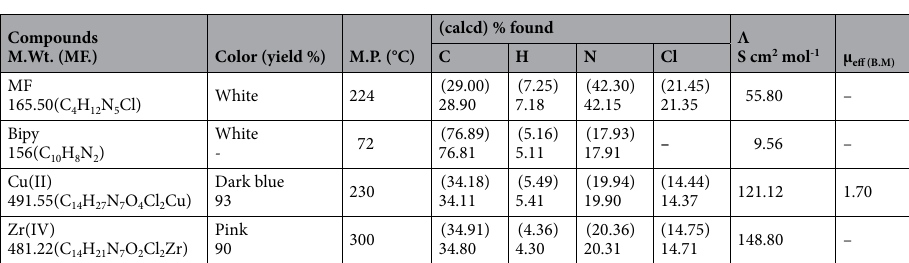
Table 1. Elemental analysis and physico-analytical data for MF, Bipy and their metal complexes.